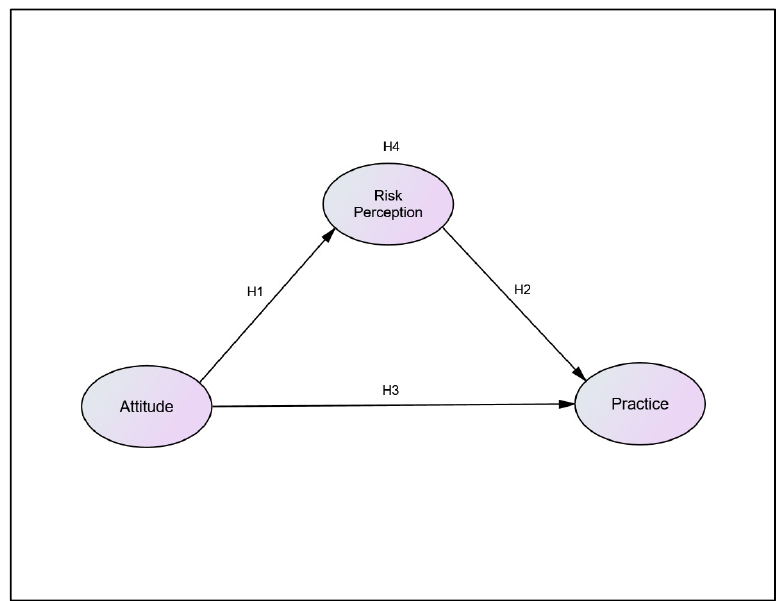
Figure 1. Theoretical framework of risk perceptions, attitudes, and dengue preventative practices.